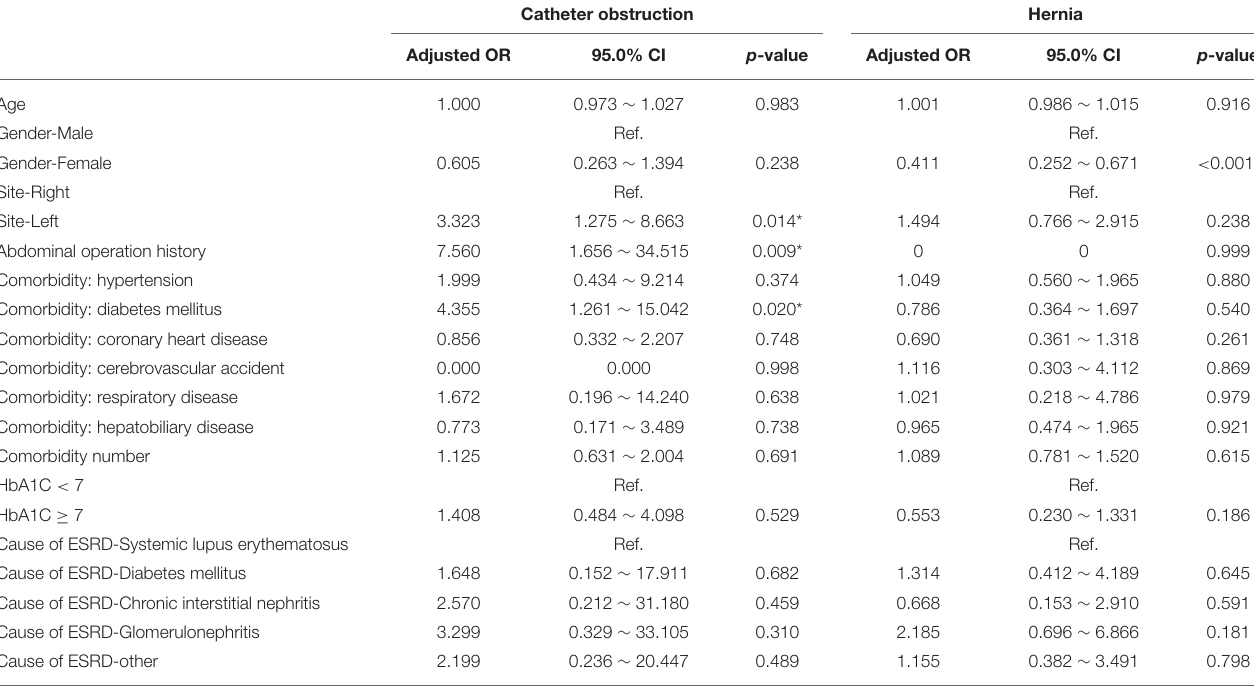
TABLE 4 | Multiple logistic regression analysis of factors influencing catheter obstruction and hernia after